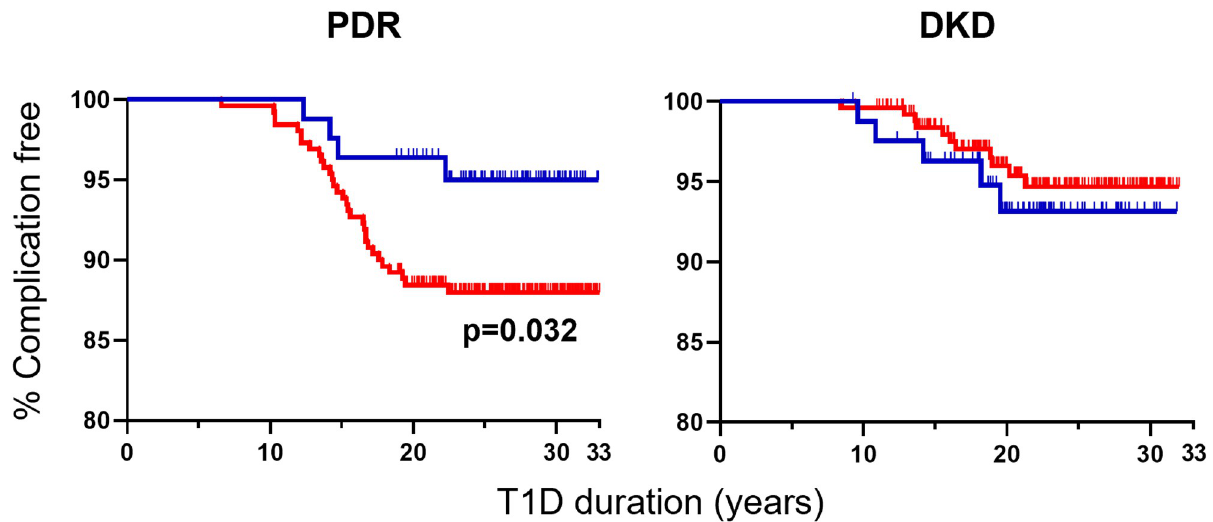
Fig 2. Association between INS variation and complication probability during secondary intervention. The complication free probability of PDR (left) and DKD (right) is shown for type 1 diabetes patients carrying the protective (blue) and susceptible (red) INS variant in the secondary intervention group of the DCCT/EDIC intensively treated study arm. Significantly fewer individuals carrying the protective INS variant developed PDR (4 of 83) compared to those with the susceptible INS variant only (31 of 260). The probability for developing DKD was not different between individuals carrying the protective INS variant (5 of 83) compared to those with the susceptible INS variant only (11 of 260). Homozygous and heterozygous protective patients were combined due to low numbers of protective homozygotes. Statistical significance was determined using a one-sided log rank test and indicated if p <